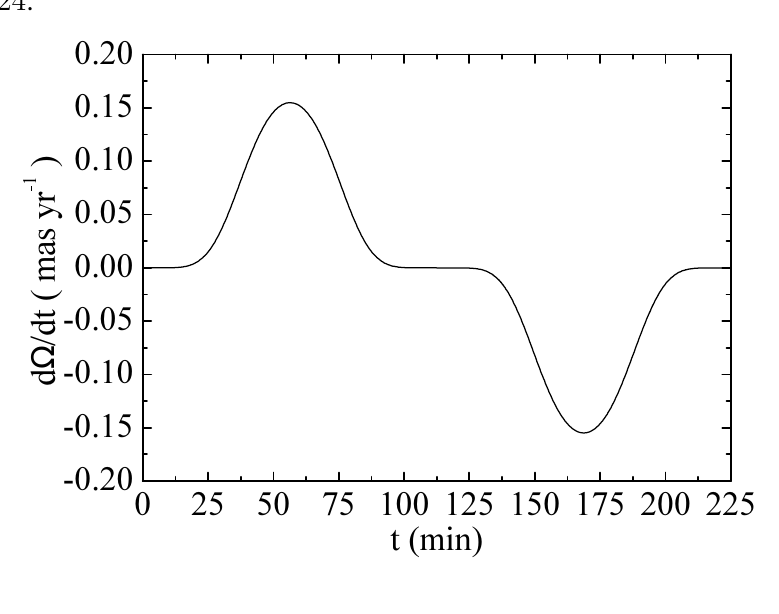
Figure 4. Instantaneous advance of the longitude of the ascending node for the LAGEOSsatellite in a single orbit, as determined from Equation (28), in milliarcseconds per year. Time, t , is measured in minutes. The parameters for the model are n = 4 , m = 5 and β = 0 . 6824